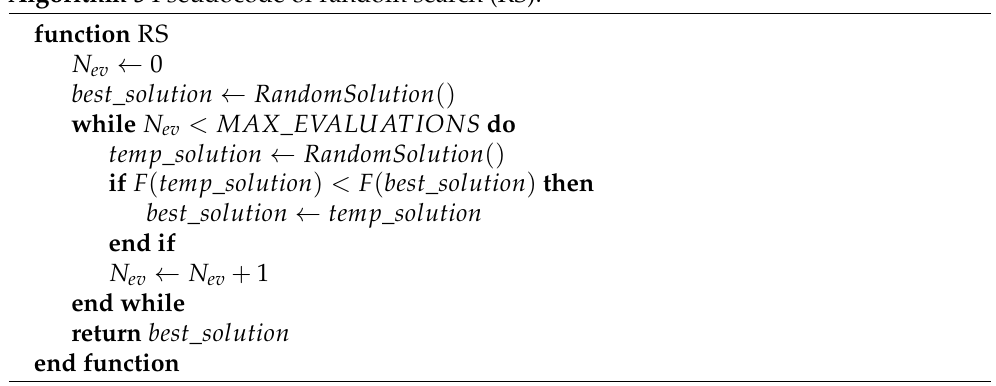
Algorithm 5 Pseudocode of random search (RS).